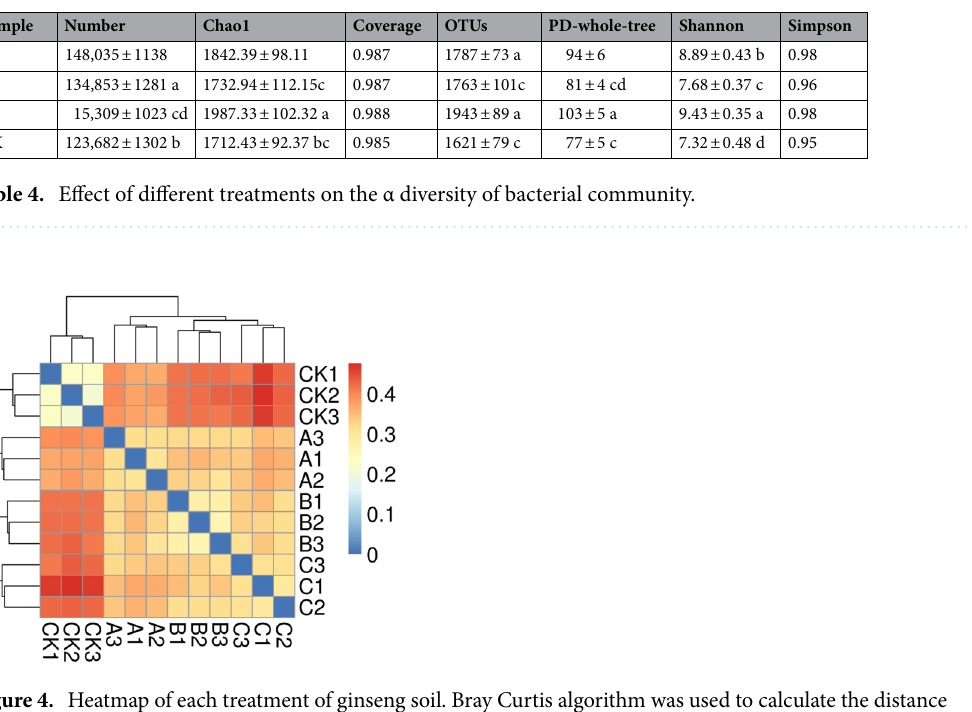
Figure 4. Heatmap of each treatment of ginseng soil. Bray Curtis algorithm was used to calculate the distance between the two samples and obtain the distance matrix. The distance among samples is represented by a color gradient. Created using Mothur1.43.0 software (http:// mothur.